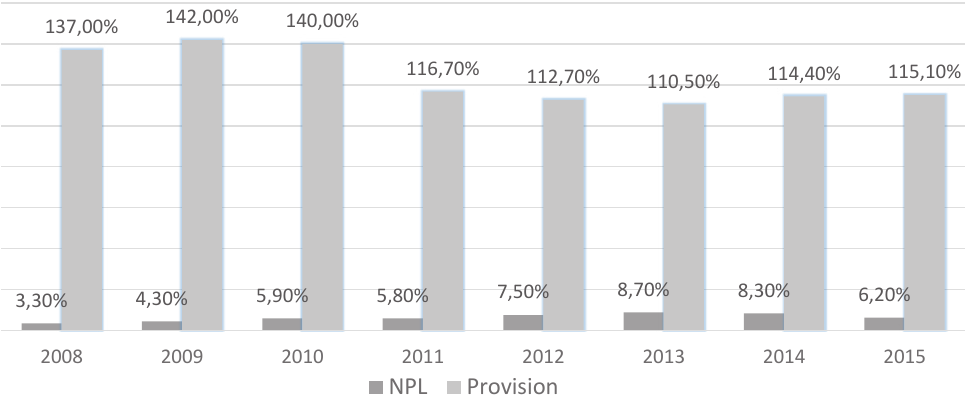
Figure 1. NPL and provisions for the period of